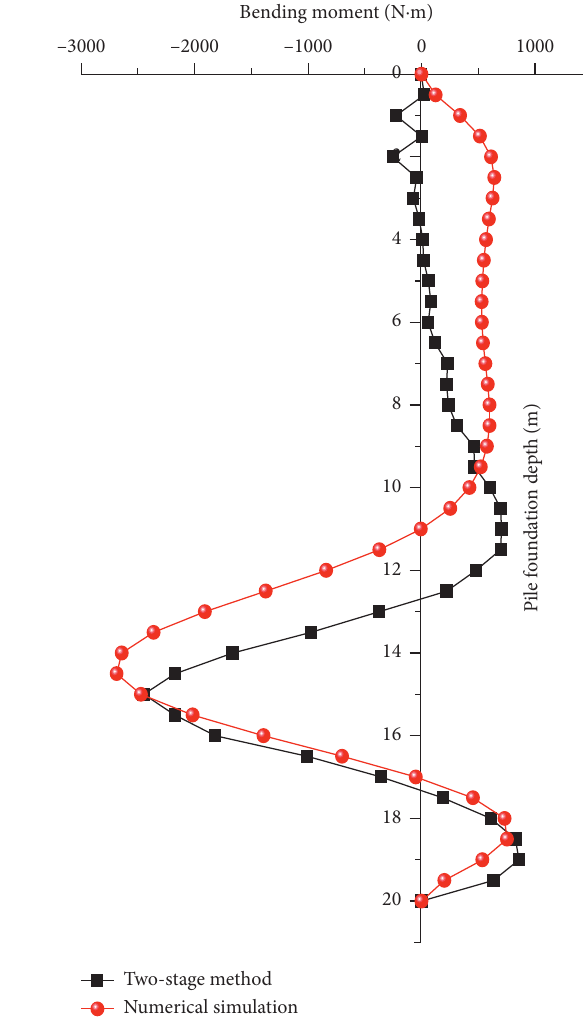
Figure 9: Shear force of pile. Figure 10: Bending moment of